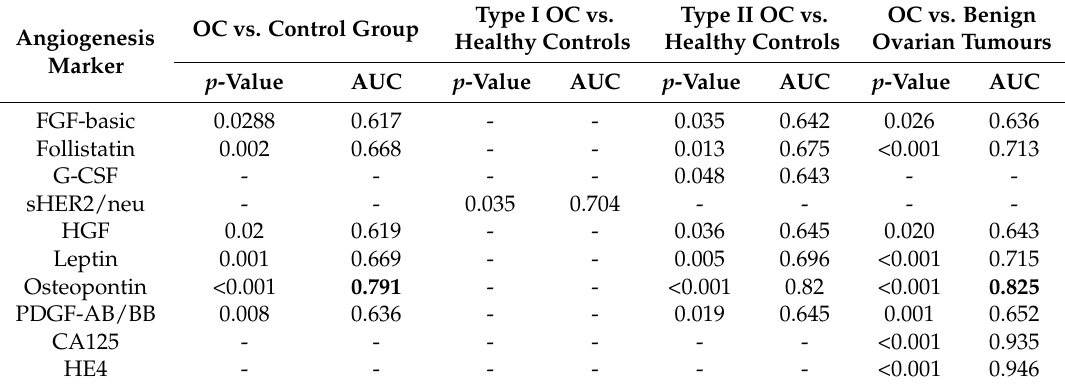
Table 2. Discriminatory value of serum angiogenesis markers expression showing significant p -values ( p < 0.05) and area under the receiver operating characteristic (ROC) curve (AUC > 0.610) between studied